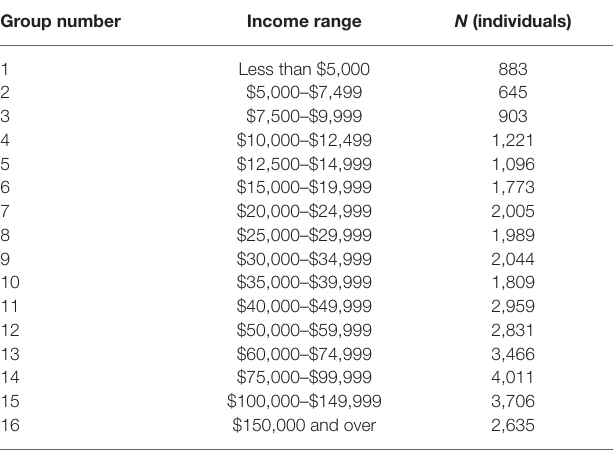
TABLE 1 | The original categories of income in the ATUS family income measure with number of individuals in each income category in the ATUS 2010, 2012, and 2013 well-being